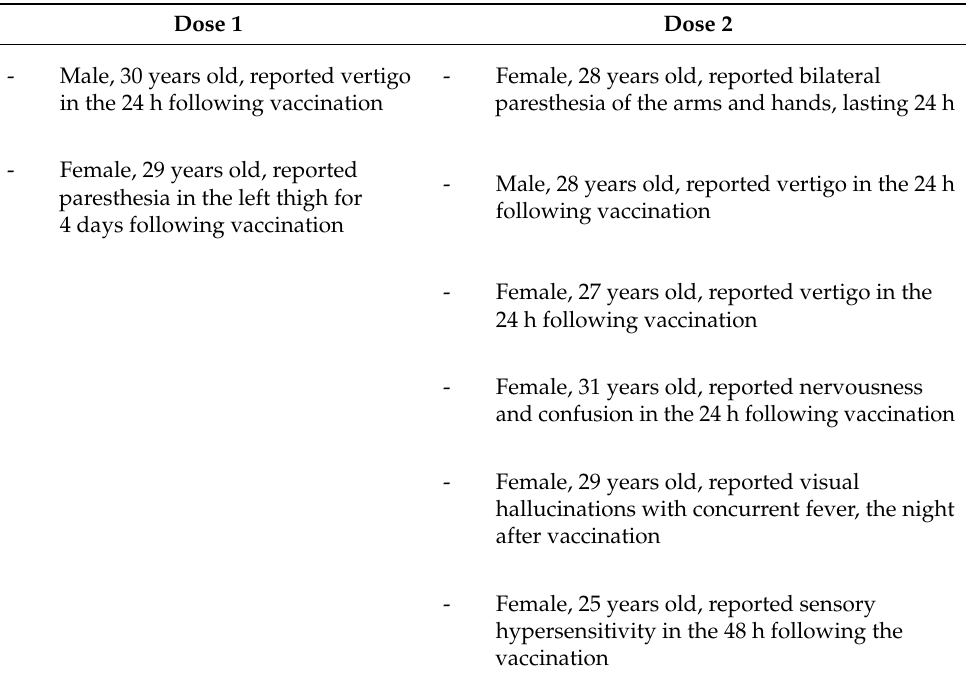
Table 4. Narrative description of cases reporting neurological symptoms included in the